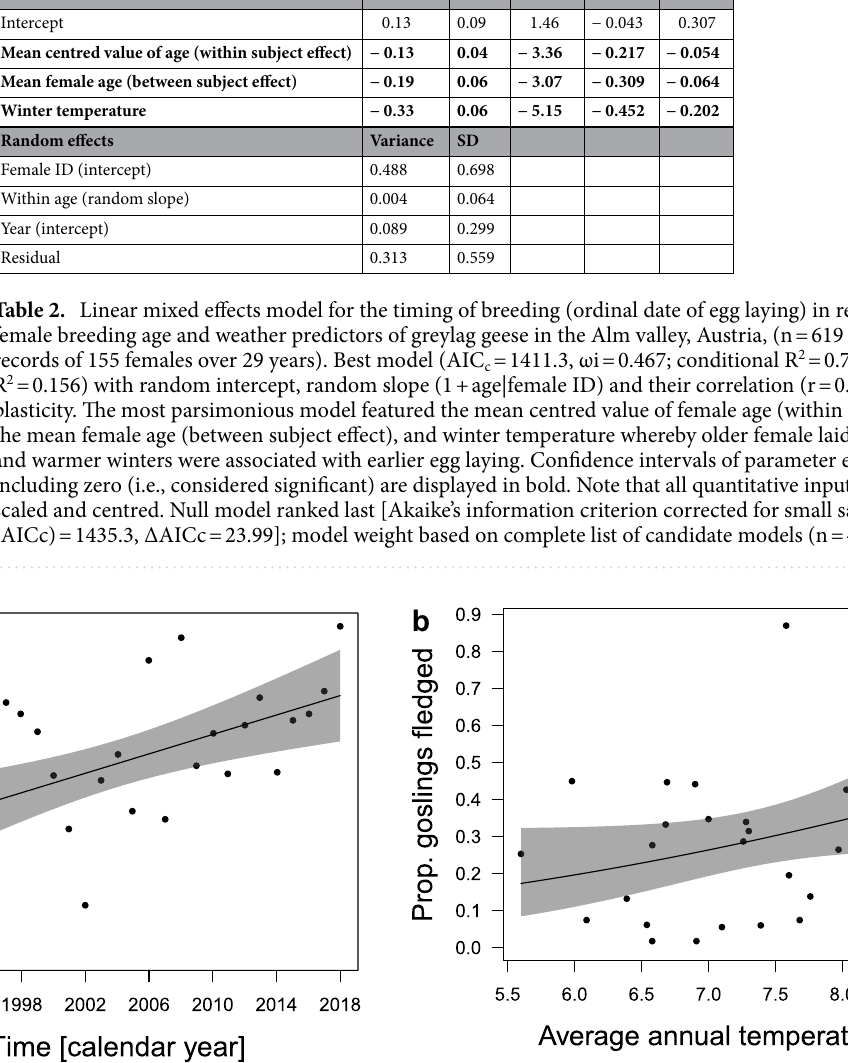
Figure 5. Relationship between the ( a ) average clutch size in the flock and annual variation over time (estimate 0.72 ± 0.25 SE, 0.208 LCI 1.232 UCI); and, ( b ) proportion of fledged goslings in the flock and average annual temperature (estimate 0.47 ± 0.28 SE, 0.029 LCI 0.901 UCI) in greylag geese in the Alm valley, Austria, between 1990 and 2018. The line is the predicted relationship based on the output of the linear model for average clutch size and beta regression model for proportion fledged goslings (Table 3), with 95% CIs in shaded grey. Dots represent the raw